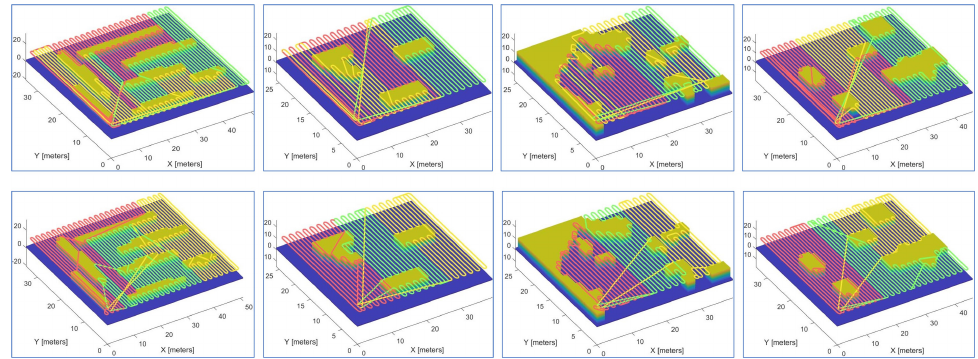
Figure 14. Coverage paths of DCRC ( first row ) and CDM ( second row ) with three robots.